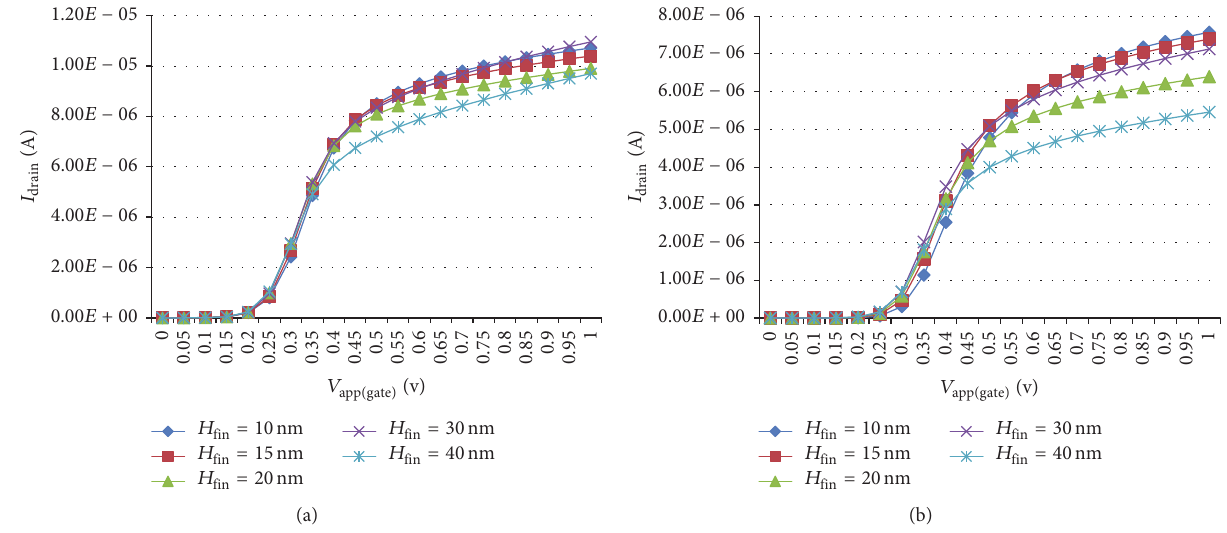
Figure 4: Transfer characteristics of triangular FinFET. (a) For low doping level (10 15 /cm 3 ). (b) For high doping level (10 18 /cm 3 ).